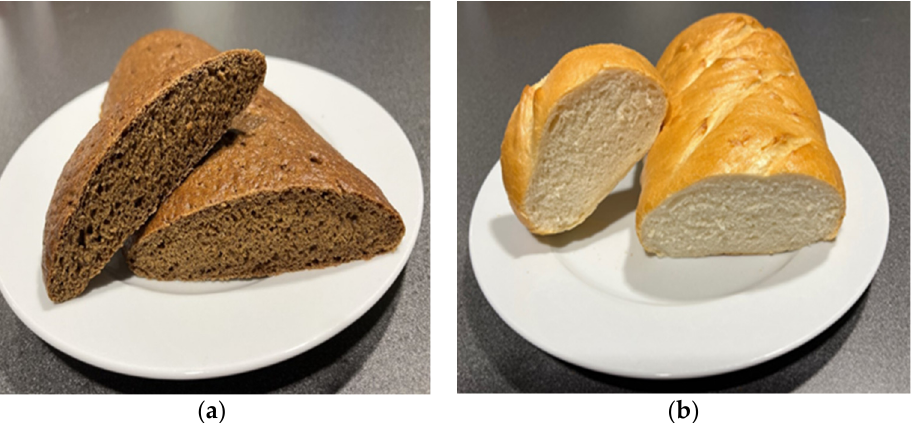
Figure 2. Bread prototype ( a ) consists of 50% oyster mushroom cultivation residue and 50% refined wheat flour. White bread ( b ) consists of 100% refined wheat flour.